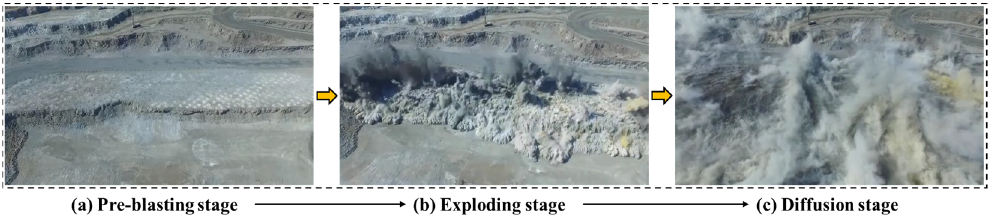
Figure 4. Frame pictures of pre-blasting, exploding stage and diffusion stages extracted from the UAV video data. UAV video